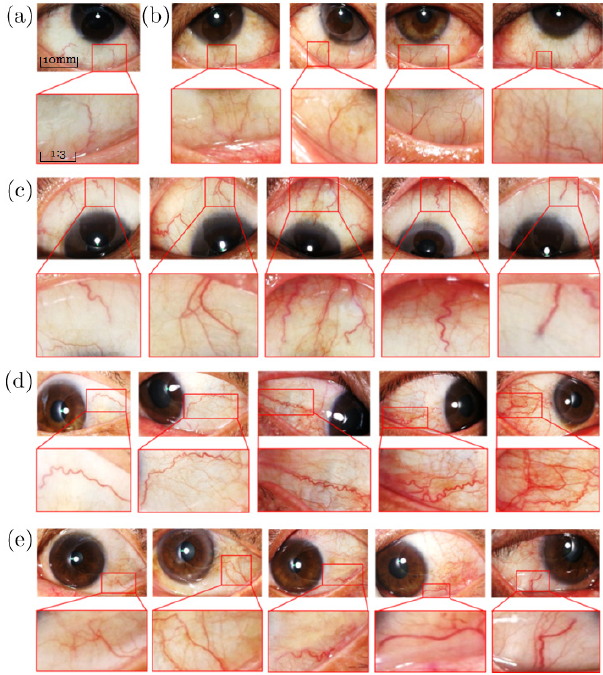
Fig. 4. Eye-feature images taken by di®erent imaging meth- ods: (a) askiatic imaging, (b) eyeball wide-¯eld imaging, and (c) slit-lamp imaging.